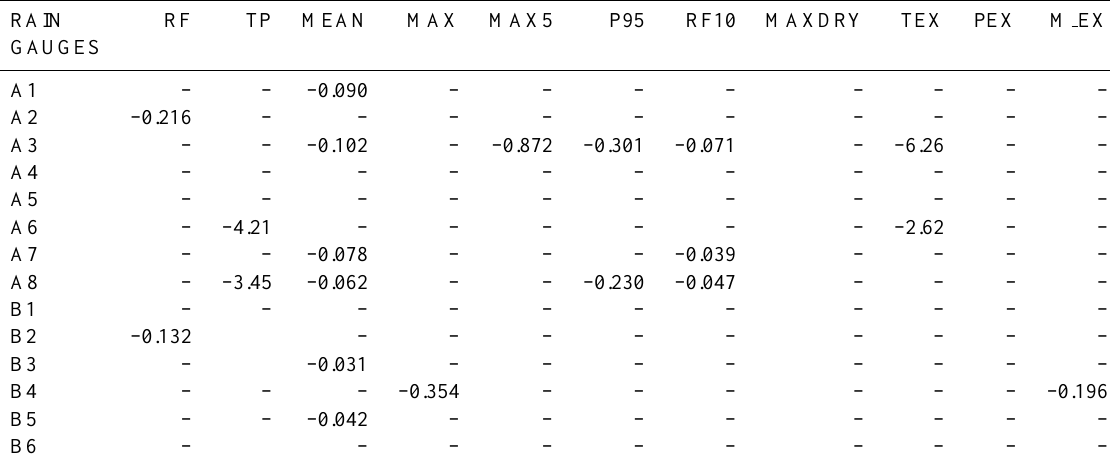
Table 2. Significant trends ( p < 0.05) of several indexes at the annual scale: relative frequency of rainy days (RF), total annual precipitation (TP), mean precipitation in a rain day (MEAN), daily maximum (MAX), maximum 5-day precipitation total (MAX5), percentile of order 0.95 based on wet days (P95), relative frequency of days with precipitation ≥ 10mm (RF10), maximum number of consecutive dry days (MAXDRY), annual accumulation of rainfall extremes (TEX), proportion of annual accumulation due to extreme events (PREX), mean of extreme events (M